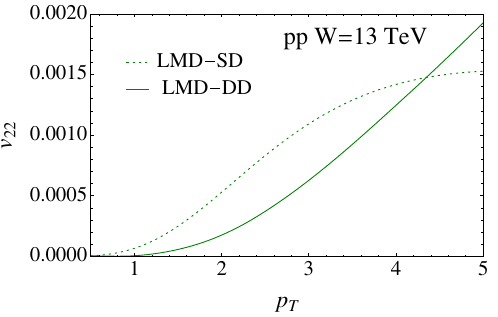
Fig. 11 The contribution to v 22 versus p T at W = 13TeV for large mass diffraction in single (LMD-SD) and in double (LMD-DD)